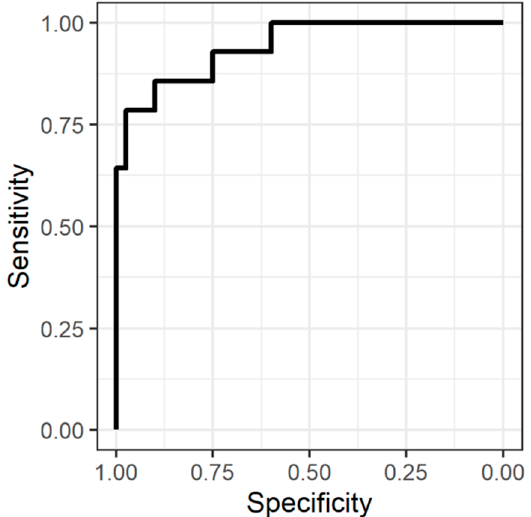
Figure 4. ROC curve showing the sensitivity and specificity of LTH, 2 min for identification of legs with a critical decrease in TcPO 2 (<20